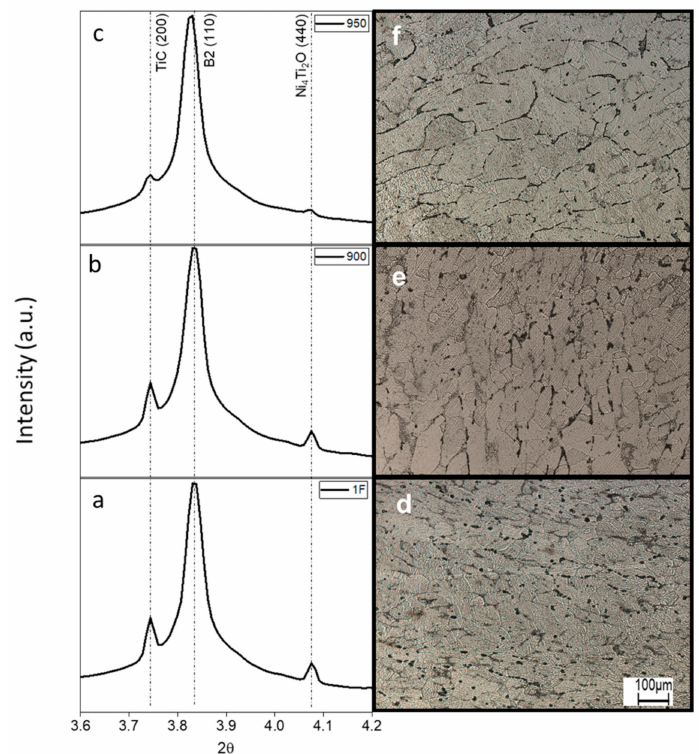
Figure 4. XRD diffractograms and microstructure at as-forged ( a , d ) and heat-treated at 900 ( b , e ) and 950 ( c , f ) samples at room temperature.